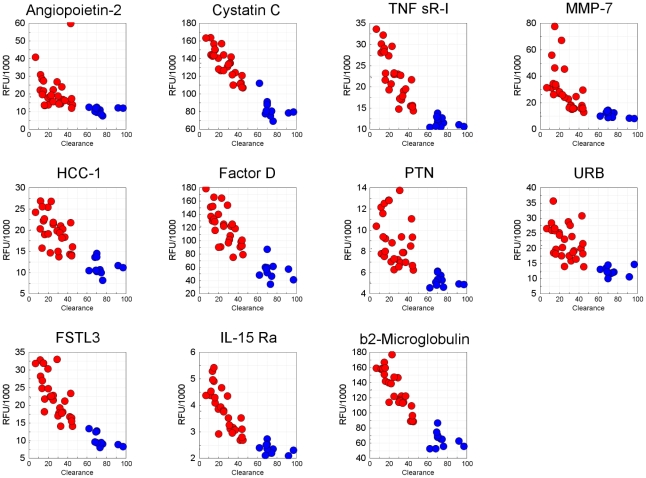
Potential CKD biomarkers.Eleven analytes with the smallest q-values (<3.5×10−7). Protein concentrations (expressed as RFU values) as a function of renal clearance for the eleven best biomarkers of late-stage (red circles) vs. early-stage CKD (blue circles).